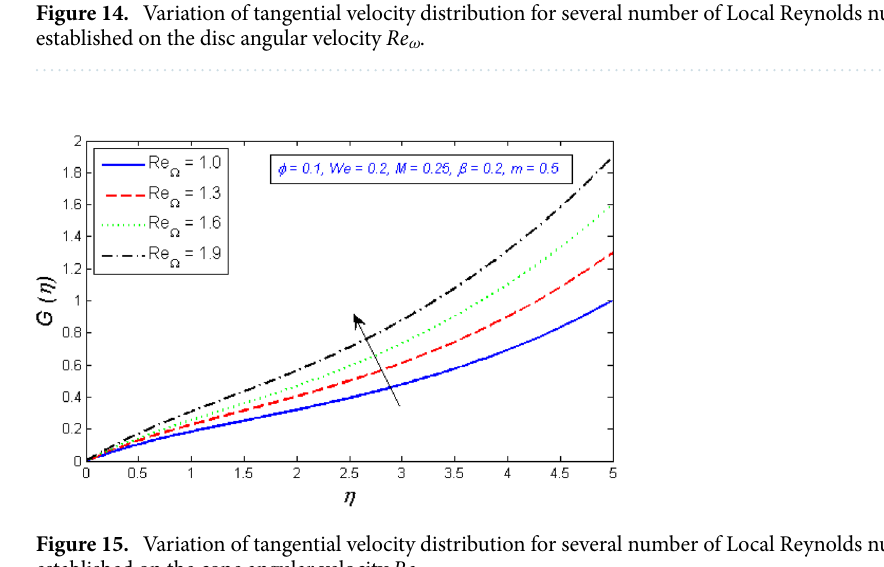
Figure 12 and 13 depict the behavior of the radial velocity in relation to the impact of the two Reynolds numbers, Re ω & Re (cid:31) . It is discovered that as the two Reynolds numbers raise, the radial velocity significantly